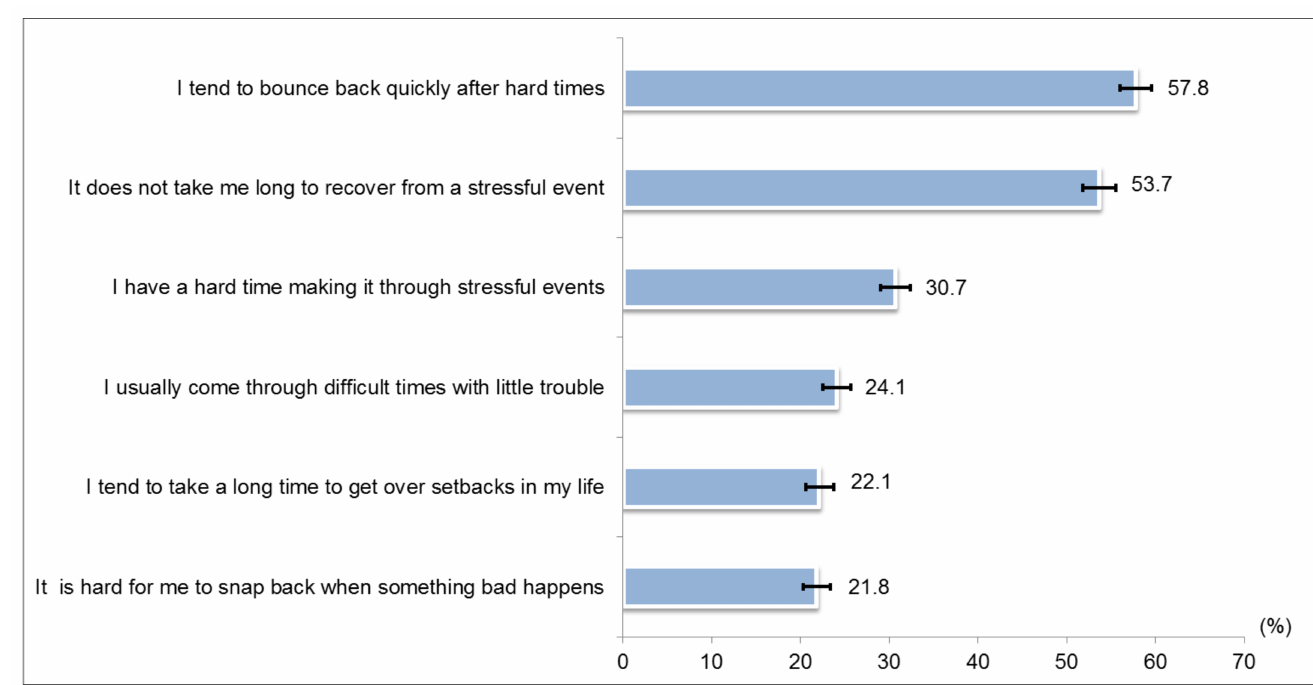
Figure 3. Proportion of ‘strongly agree/agree’ responses for Brief Resilience Scale items (N =